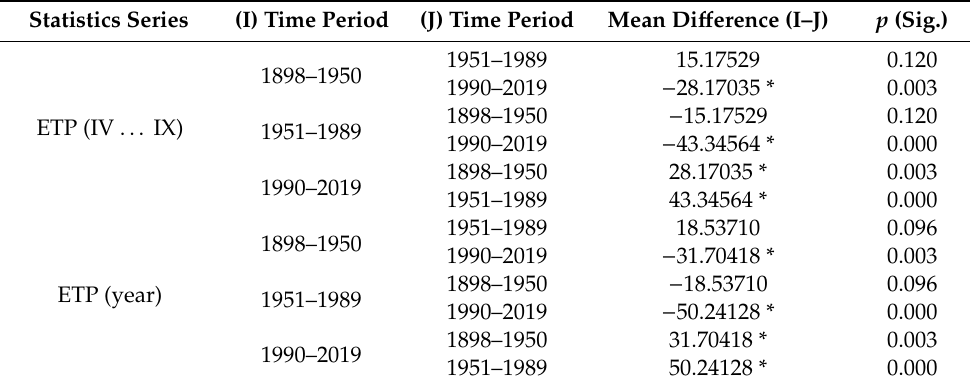
Table 2. Multiple comparisons using Tukey Post Hoc between the average values of the analyzed time periods for cumulative evapotranspiration values (ETP IV ... IX) from April (IV) to September (IX), respectively, throughout the year (ETP year), registered annually at the Regional Meteorological Center Banat-Crisana, Romania (expressed in